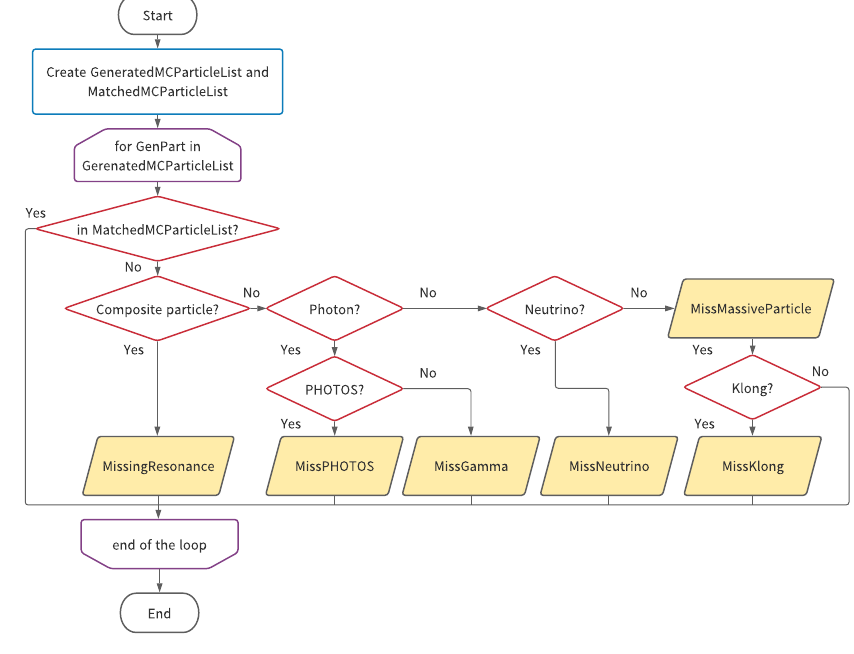
Figure 2. The algorithm flowchart of the evaluation for existing particles Figure 3. The algorithm flowchart of the evaluation for missing particles